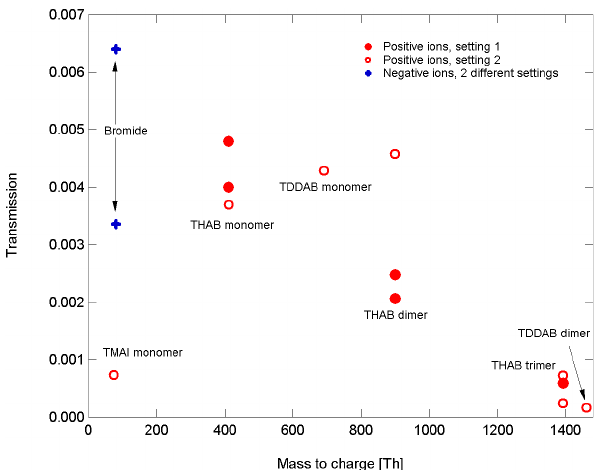
Fig. 6. Ion transmission efficiency for APi-TOF using electro- sprayed mobility standards and nano-DMA for mobility separa- tion. TMAI – tetramethyl ammonium iodide, THAB – tetra-heptyl ammonium bromide, TDDAB – tetradodecyl ammonium bromide. Transmission is the fraction of ions reaching the detector out of the ions at inlet.